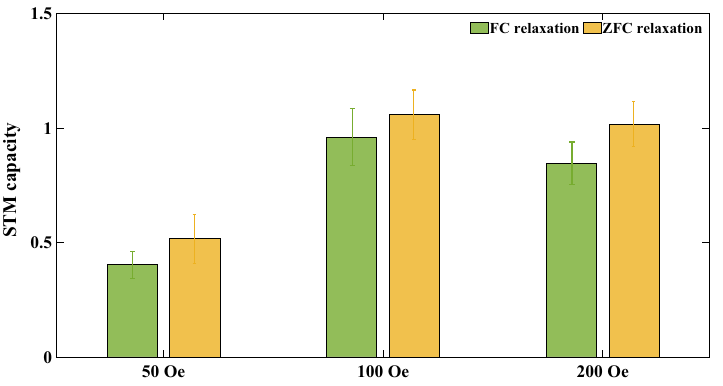
Figure 7. Short-term memory capacity of LFCS when the input binary sequence is mapped from {0, 1} to ( a ) {0, 50 Oe}, ( b ) {0, 100 Oe}, and ( c ) {0, 200